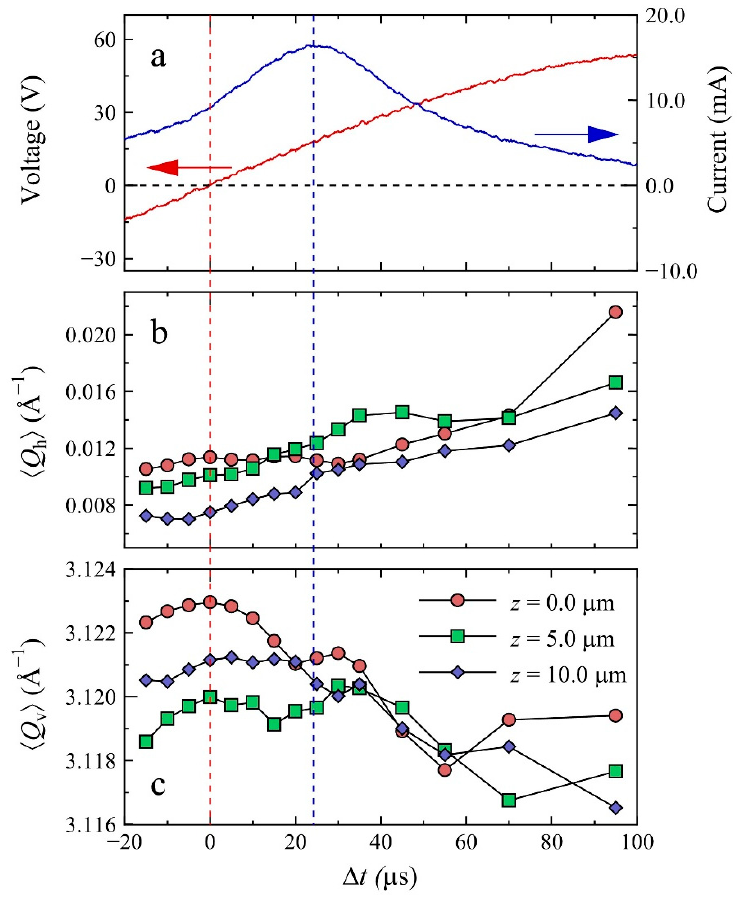
Figure 5. Time ( ∆ t ) dependences of ( a ) voltage (red) and current (blue) between two electrodes on the crystal surfaces, and ( b ) (cid:104) Q h (cid:105) and ( c ) (cid:104) Q v (cid:105) at local locations of z = 0.0, 5.0, and 10.0 µ m in the time-resolved nanobeam XRD for local structure under AC field. Red and blue dashed lines indicate times when the voltage becomes zero at ∆ t = 0 and the current becomes the maximum at ∆ t = 24 µ s, respectively.